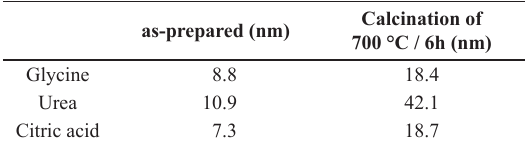
Table 1. Average crystallite size of powders synthesized by solution combustion as prepared and